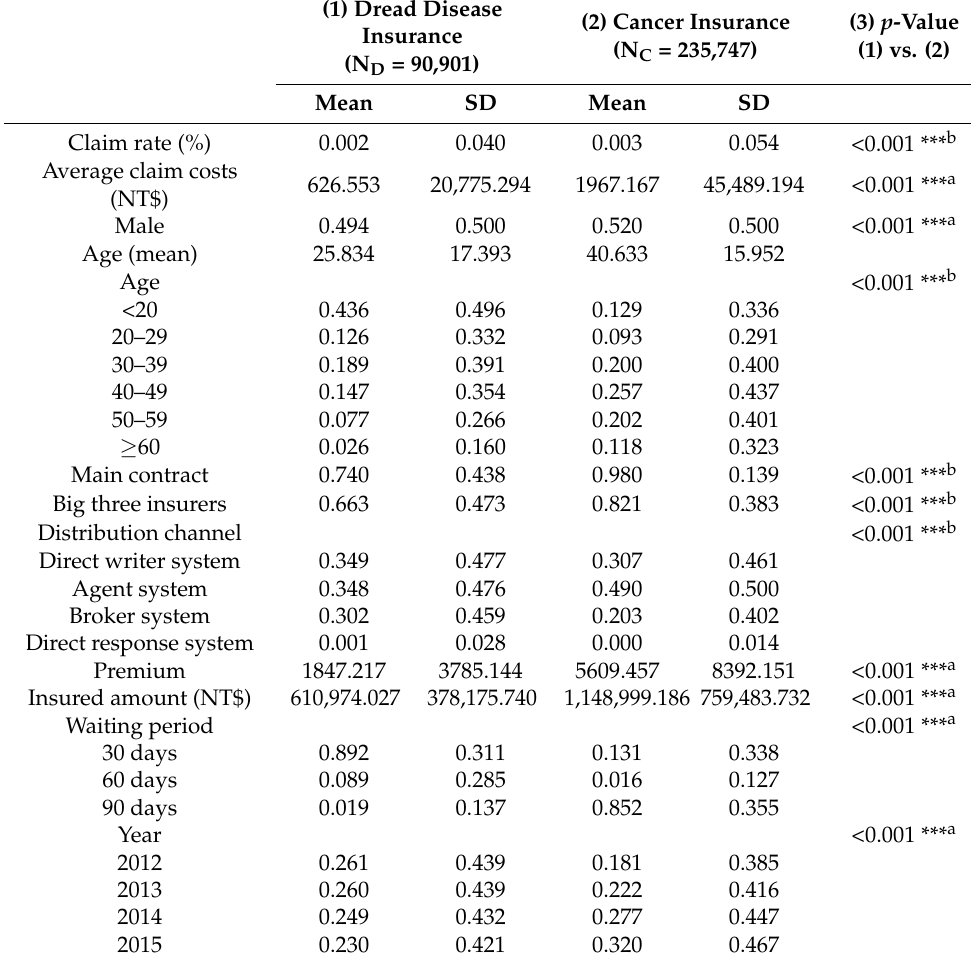
Table 1. Descriptive statistics of dread disease insurance and cancer insurance